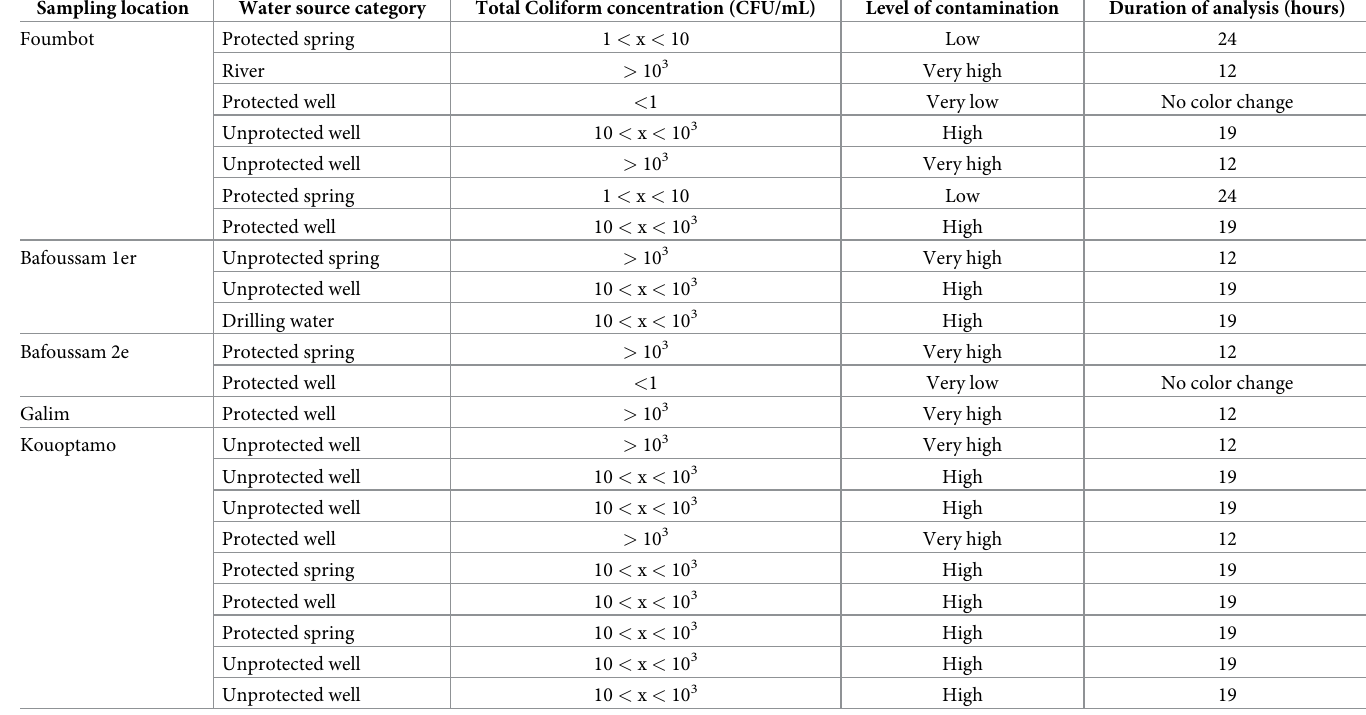
Table 2. Total Coliforms concentration in water samples, level of contamination and time of analysis, West region, Cameroon, 2018. Sampling location Water source